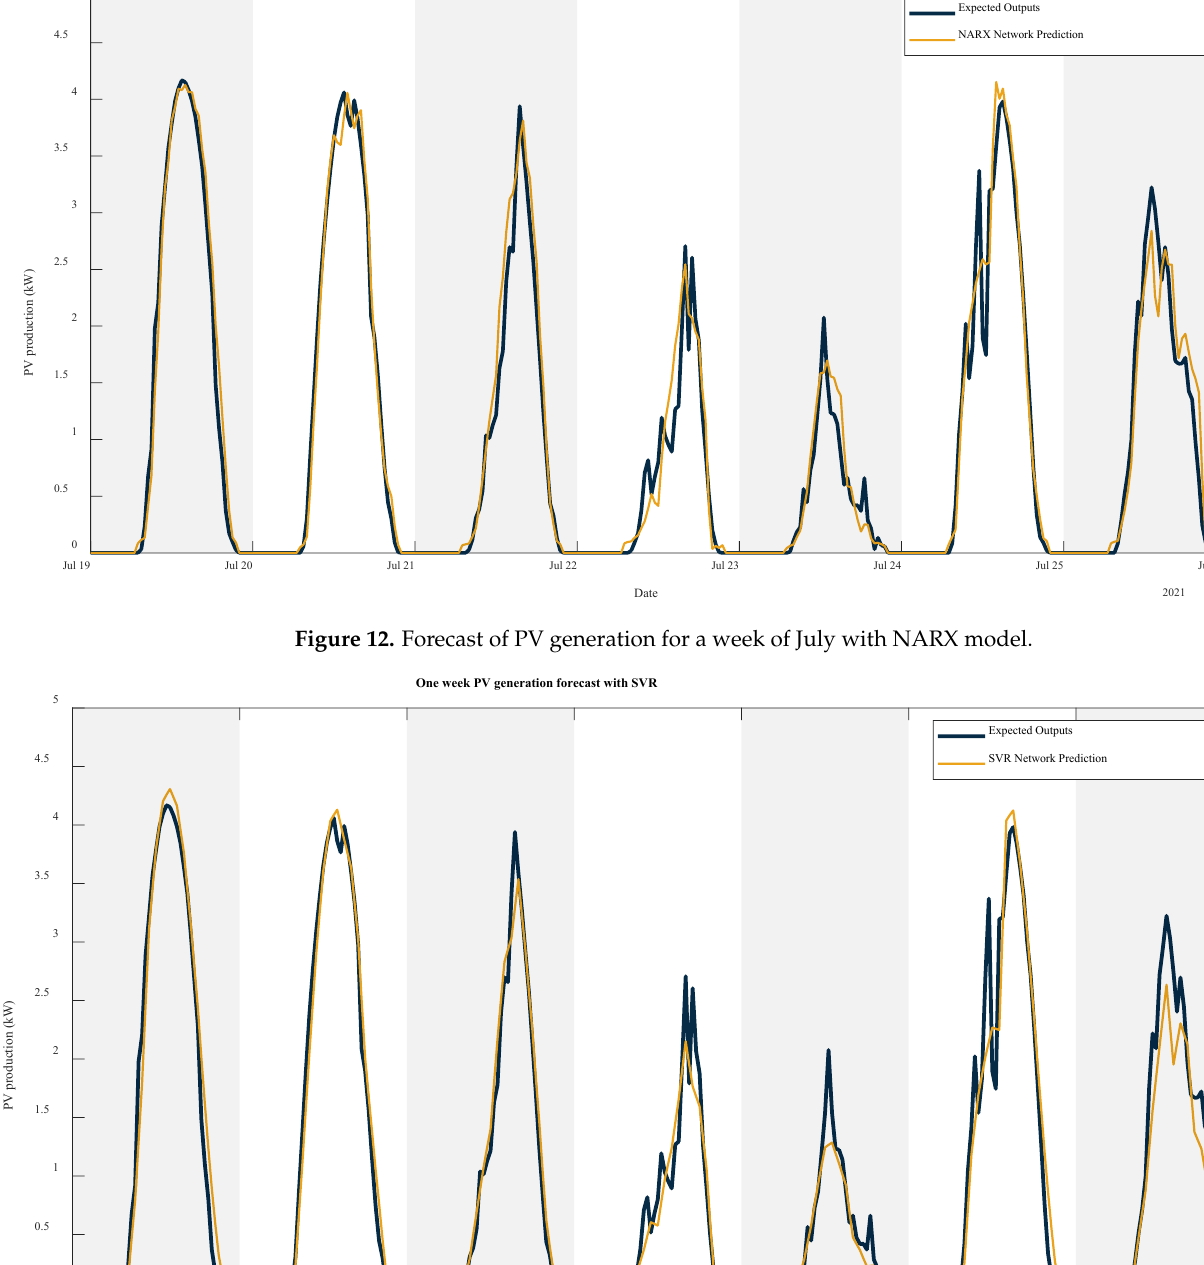
Figure 11. Forecast of PV generation for a week of July with FFNN model.